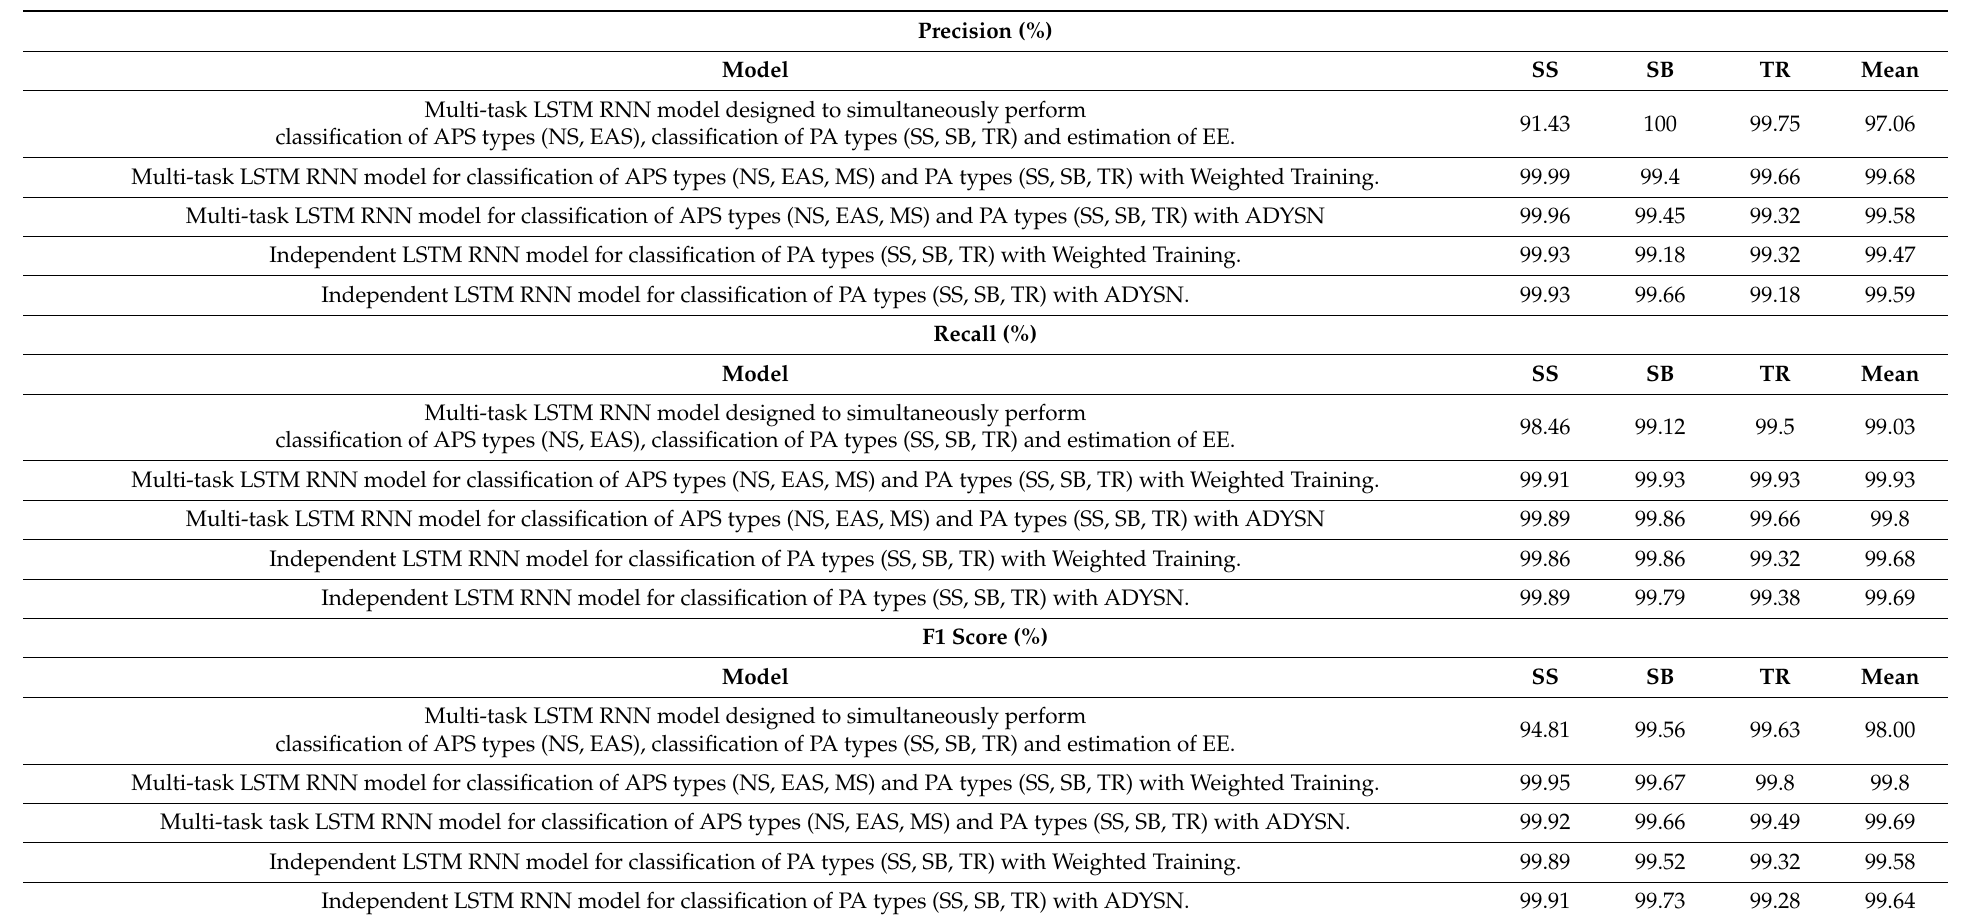
Table A1. Precision, Recall, and F1 score for PA Classification using (LSTM